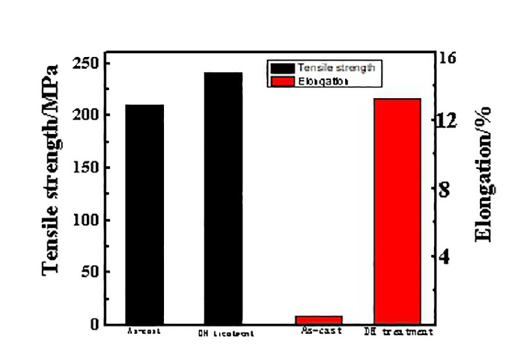
Figure 4. Variations in tensile strength, and elongation of as-cast A390-0.3wt.%Nd and extrusion and heat treatment samples Fracture surfaces of as-cast and extruded and heat